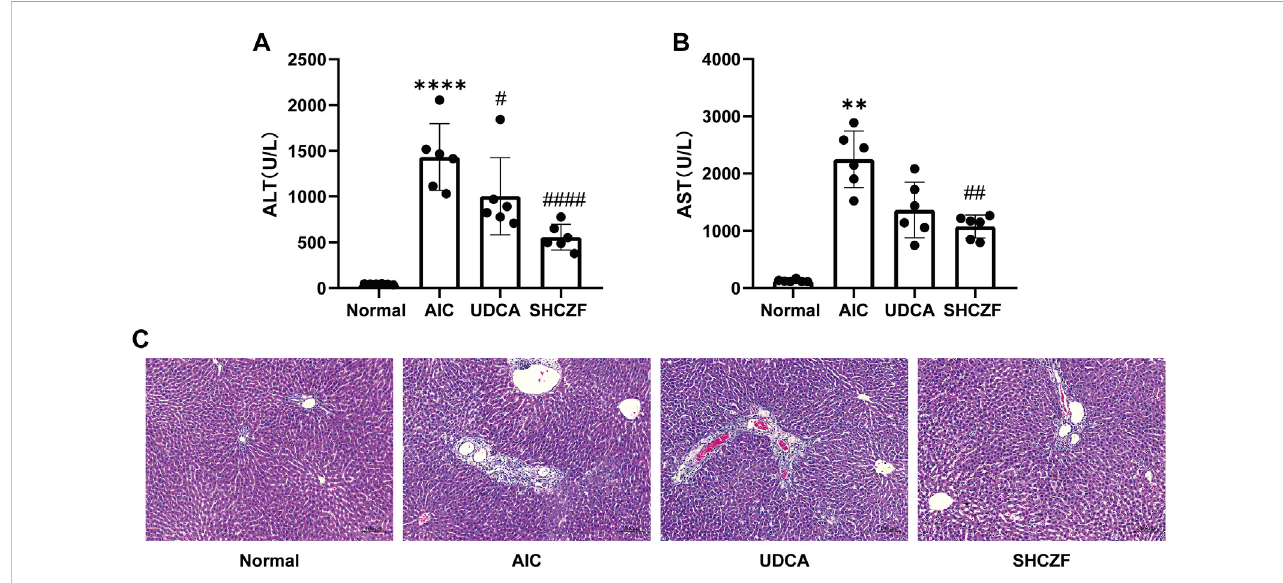
FIGURE 6 The results of hepatic injury in rats. (A) ALT level, (B) AST level, (C) HE staining